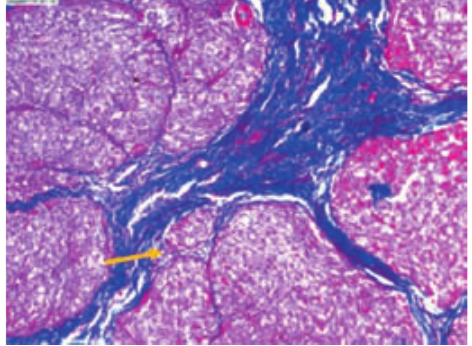
Fig. 3. Hepatoid gland epithelioma- many of cells were basaloid reserve cells and fewer hepatocytes with indistinct lobules (H&E x 200)